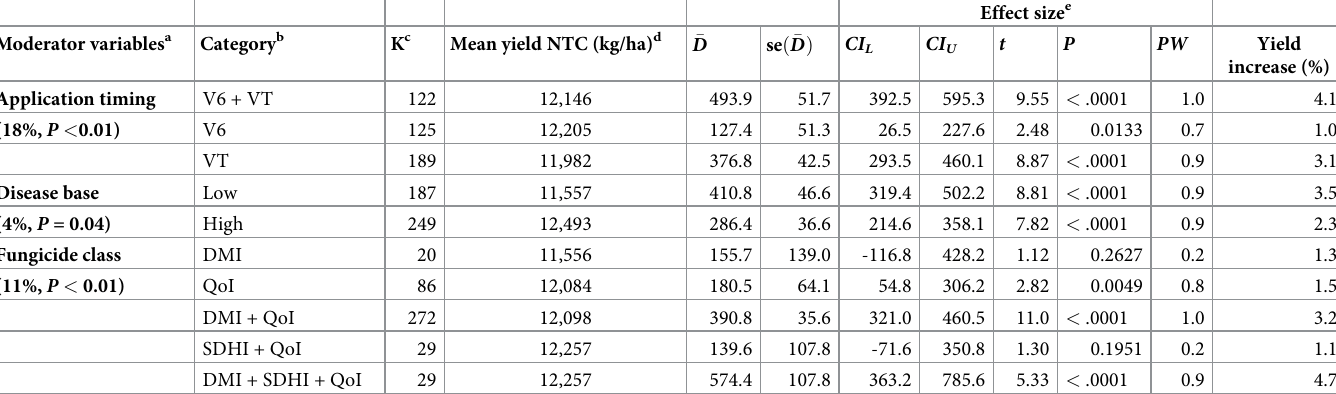
Table 3. Effect of moderator variables on yield response to fungicide, with the corresponding statistics based on mixed-effect meta-analysis for trials performed at 13 US states and Ontario, Canada in 2014 and